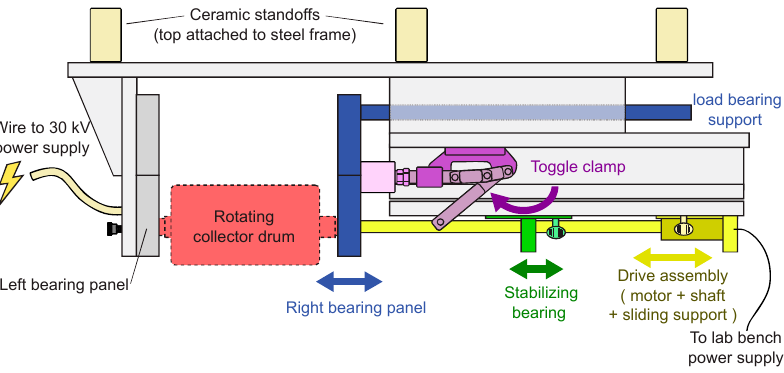
Figure 2. Collector assembly, which positions and rotates the collector drum. The collector drum can be easily removed by pulling the toggle clamp and releasing the drive assembly. The text describes the parts in more detail. Figures A1–A3. provide photographs of the assembly.